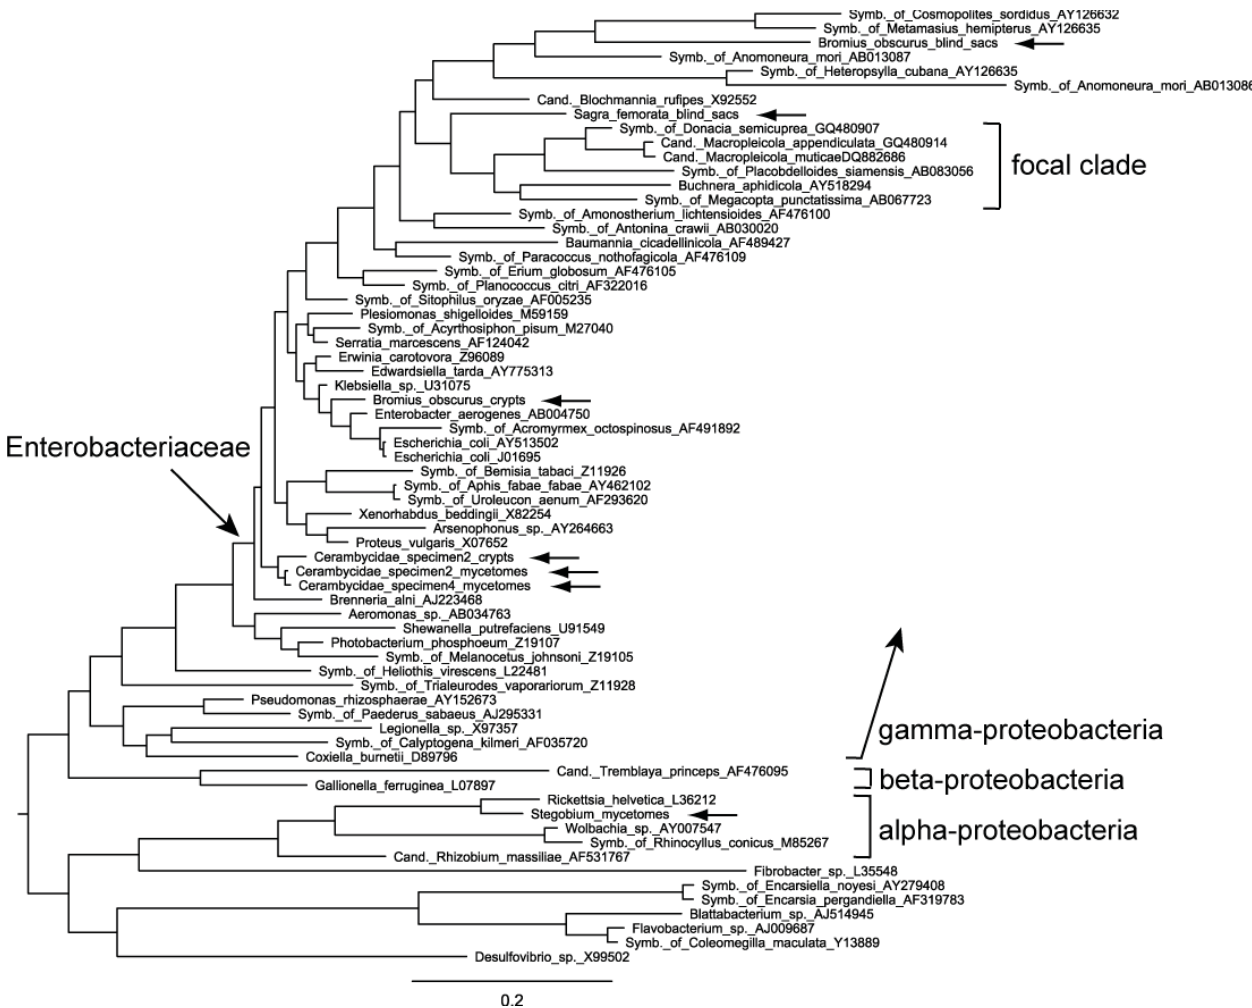
Figure 2. Phylogenetic position of the bacteria analyzed in the present study (horizontal arrows), based on partial 16S rRNA sequences (dataset ‘bacterial phylogeny’). The tree was constructed using the RNA7D model in PHASE and rooted at the base of a clade consisting of the beta- and gamma-proteobacteria. It represents a 50% majority rule tree with branch lengths estimated by the software. GenBank accession numbers are